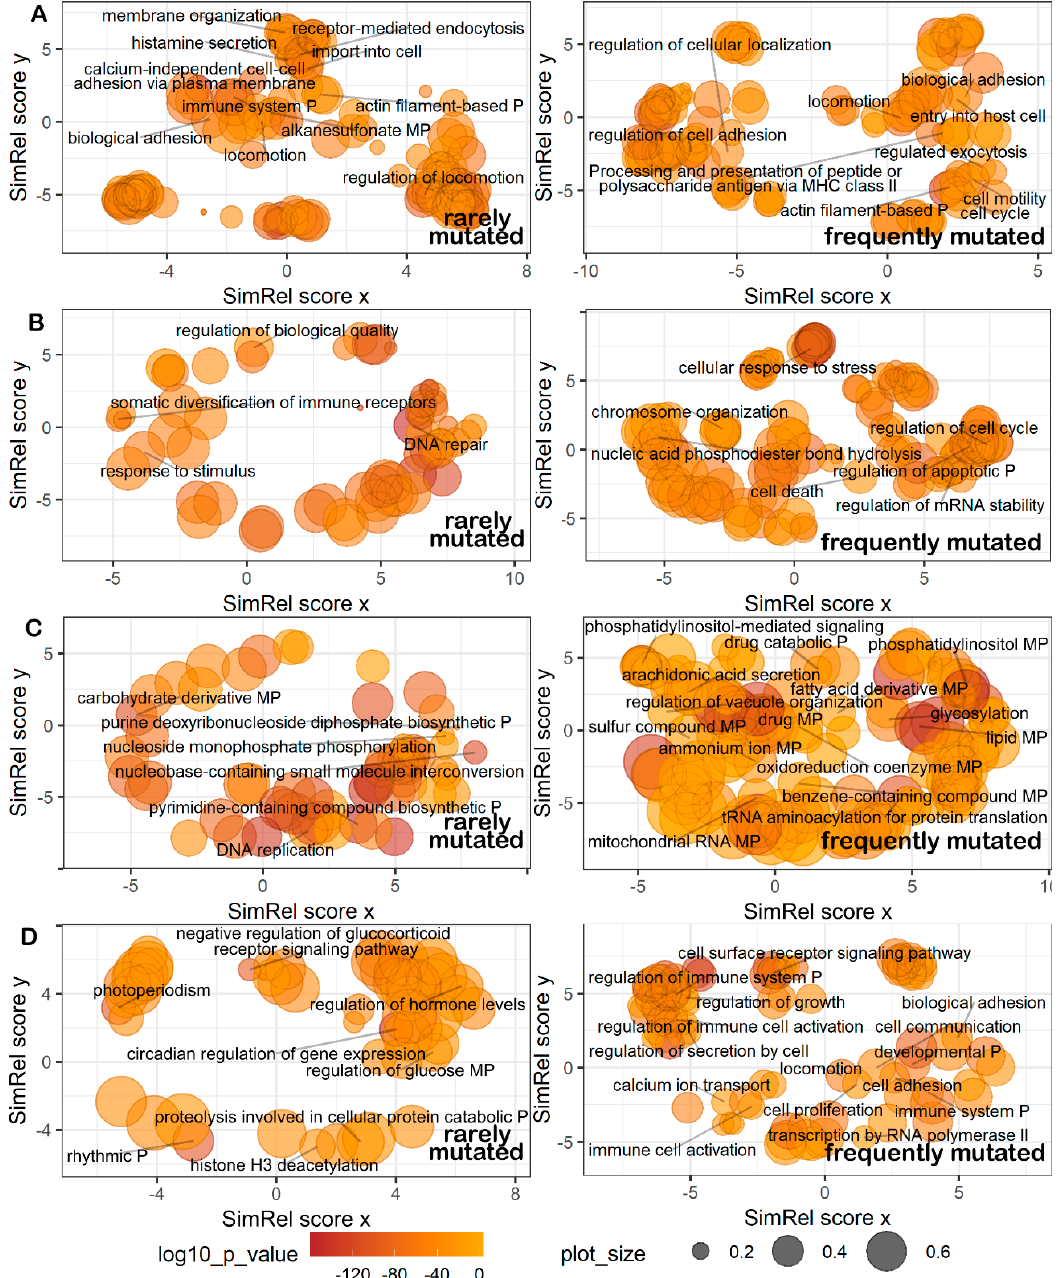
Figure 7. Representation of Gene Ontology annotations for genes from 15% least ( left ) and 15% most frequently ( right ) mutated ( A ) cytoskeleton, ( B ) DNA repair, ( C ) metabolic, ( D ) signaling pathways. Bubble size indicates the frequency of the gene ontology term in the underlying GOA database [54] (bubbles corresponding to more general terms are shown larger). “P” stands for process, “MP”—for metabolic process. Too general and non-informative gene ontology terms are not defined.